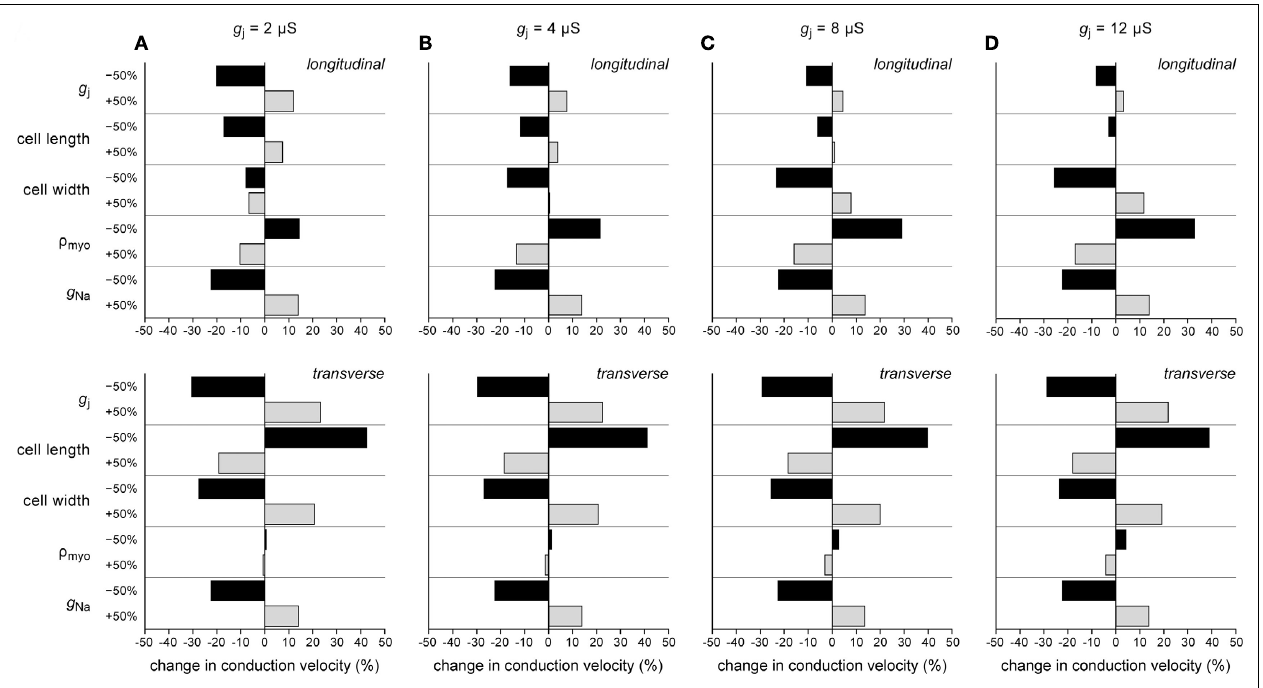
FIGURE 7 | Percent change in longitudinal (top) and transverse conduction velocity (bottom) upon − 50% or + 50% change in gap junctional conductance ( g j ), cell length, cell width, myoplasmic resistivity ( ρ myo ), or sodium current conductance ( g Na ). (A) g j = 2 μ S. (B) g j = 4 μ S. (C) g j = 8 μ S. (D) g j = 12 μ